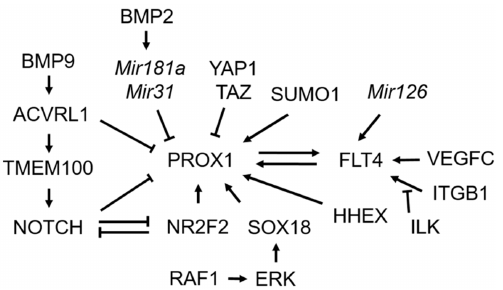
Figure 1. Genes and signaling pathways involved in the cell fate determination of lymphatic endothelial cells. PROX1 is the master regulator to determine the fate of lymphatic endothelial cells. Several genes act as transcriptional activators ( NR2F2 , SOX18 , and HHEX ) or repressors ( YAP1 and TAZ ). RAF1/ERK signaling activates SOX18 and PROX1 expression. MiRNAs, Mir181a and Mir31 , are post-transcriptional regulators of PROX1 . The sumoylation of PROX1 by SUMO1 modulates the DNA binding and transcriptional activities of PROX1. BMP2 signaling negatively regulates PROX1 expression through an increase of Mir181a and Mir31 expression. NOTCH and NR2F2 mutually inhibit their expression, and NOTCH downregulates PROX1 and NR2F2 expression via HEY1 and HEY2. BMP9/ACVRL1 signaling inhibits PROX1 expression. TMEM100, a downstream target of BMP9 / ACVRL1 signaling, activates NOTCH signaling. VEGFC is a lymphangiogenic growth factor and the ligand of FLT4. VEGFC-FLT4 signaling that is a main downstream e ff ector of PROX1 is essential for the budding-o ff of lymphatic endothelial cells from the cardinal vein. Downregulation of Mir126 attenuates FLT4 signaling. Interaction between FLT4 and ITGB1, which is interfered with by ILK (integrin-linked kinase) is important for the activation of FLT4